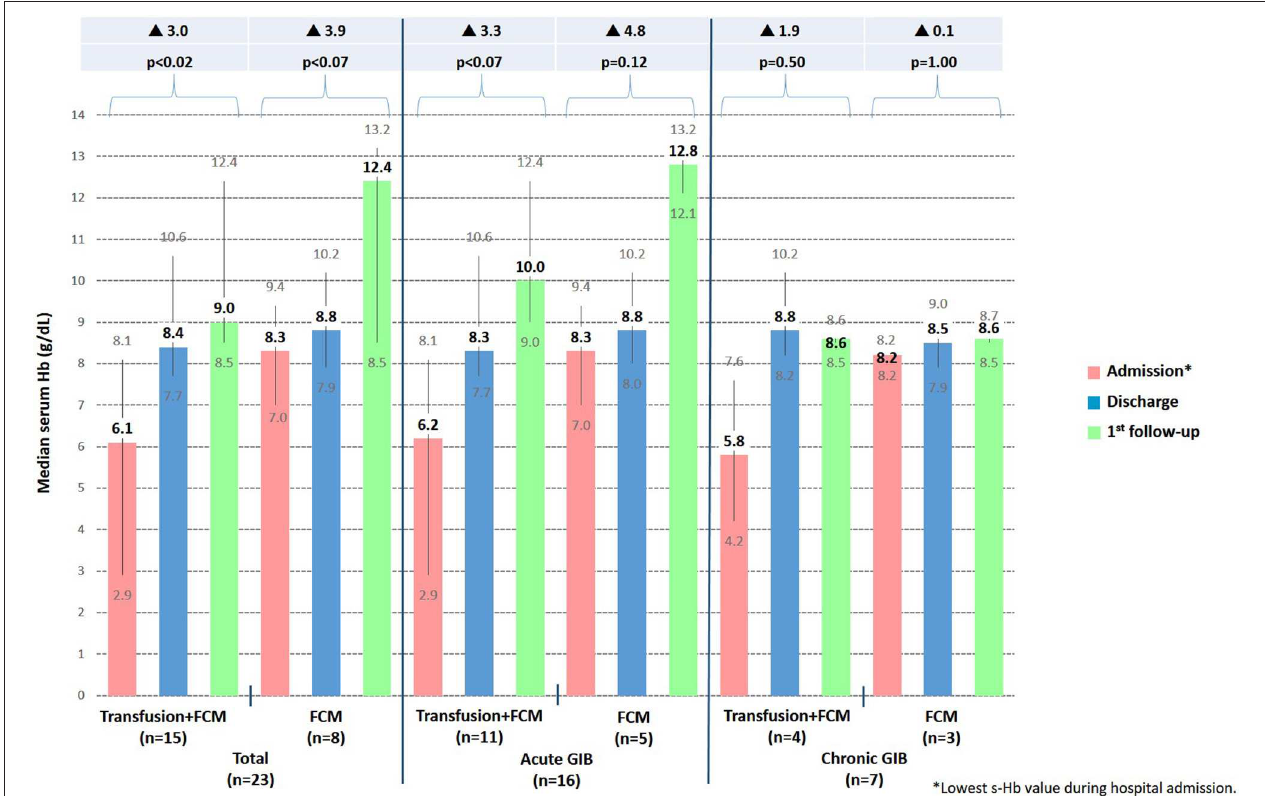
FIGURE 2 | Progression of median s-Hb levels at admission, discharge and at first visit follow-up in all 23 hospital admissions ( n = 21 patients). FCM, ferric carboxymaltose; s-Hb, serum hemoglobin; GIB, gastrointestinal bleeding.